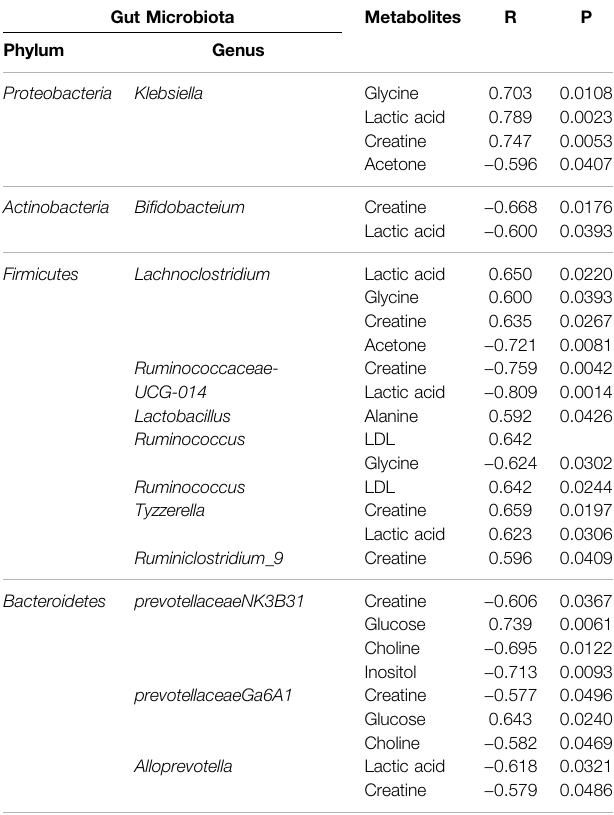
TABLE 3 | Correlations between gut microbiota and serum metabolites.